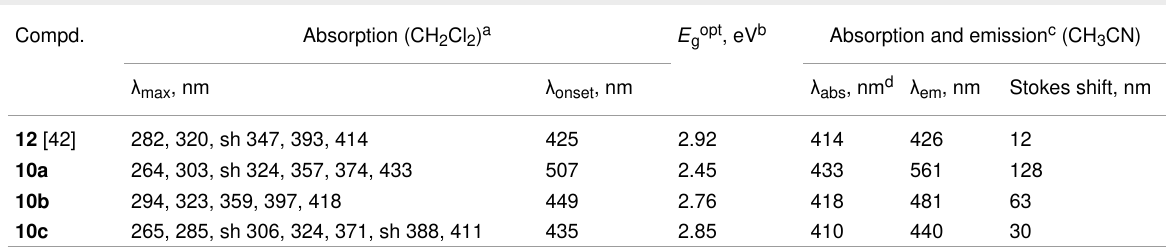
Table 7: Photophysical properties of carbazole-based [6]helicenes 10 .